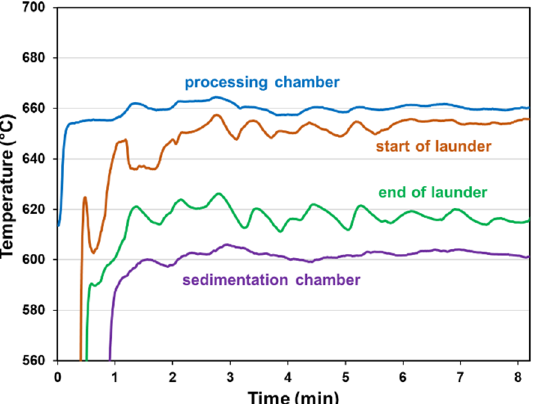
Figure 10. Temperature control in the different sections of the in-line HSMC de-ironing system processing a A380-1Mn-1Fe alloy at a melt flow rate of 4 while processing a A380-1Mn-1Fe alloy at a melt flow rate of 4 Kg/min.